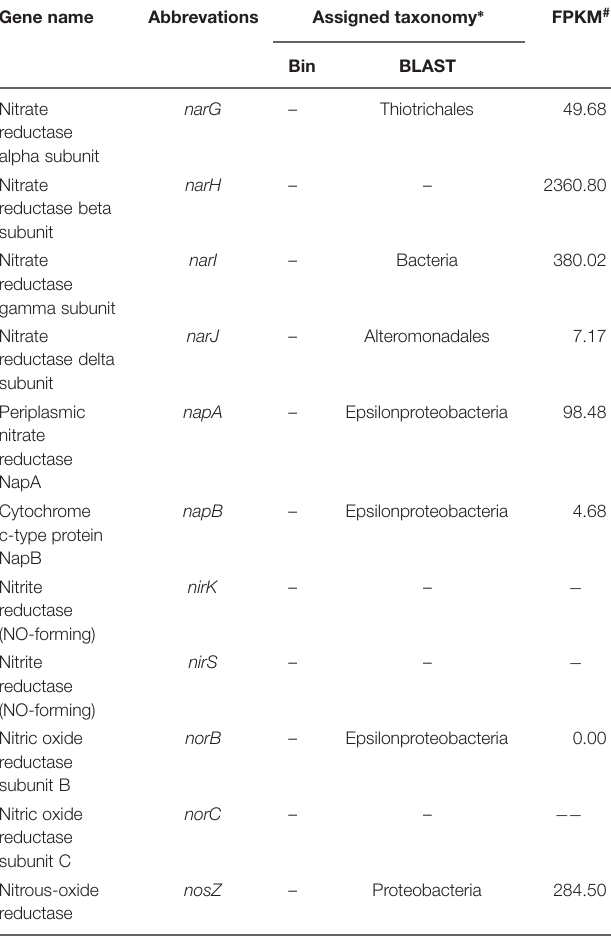
TABLE 4 | Genes identified in the nitrogen metabolic pathway in the microbial community.